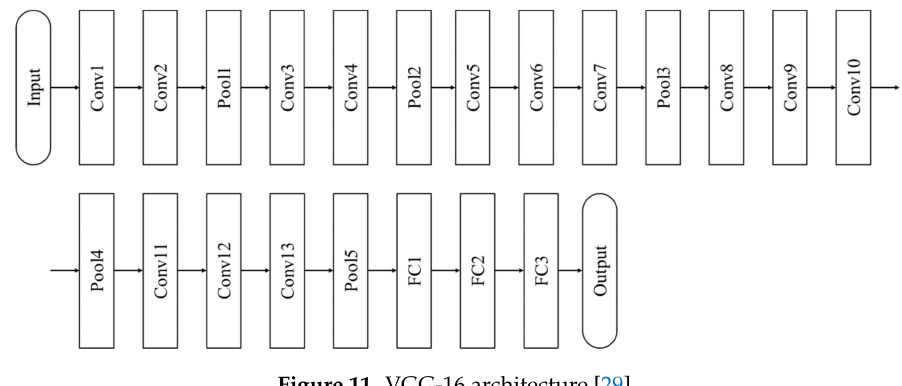
Figure 11. VGG-16 architecture [29].